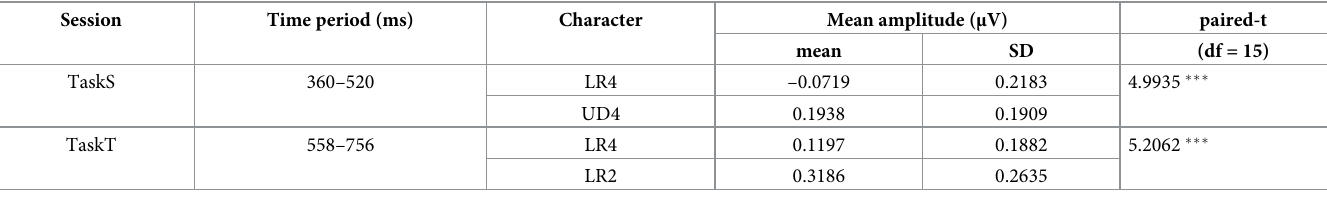
Table 7. Effects of IC3 reflecting conscious detection of abstract structural or tonal pattern. Session